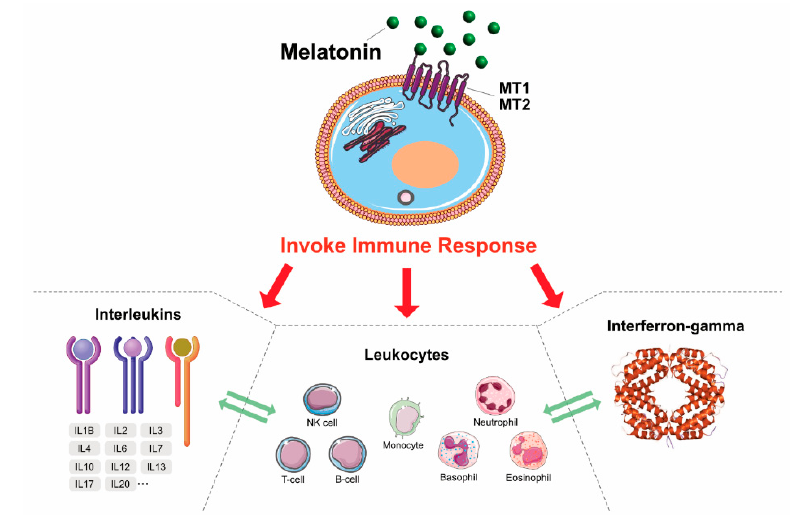
Figure 3. The immunomodulatory response of MLT in various immune cells.